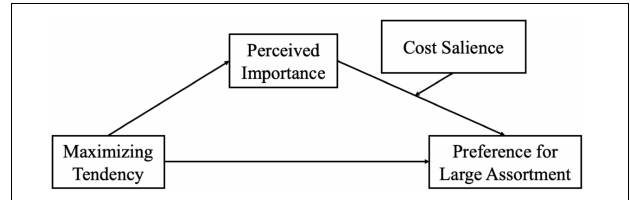
FIGURE 1 | Conceptual framework—moderated mediation